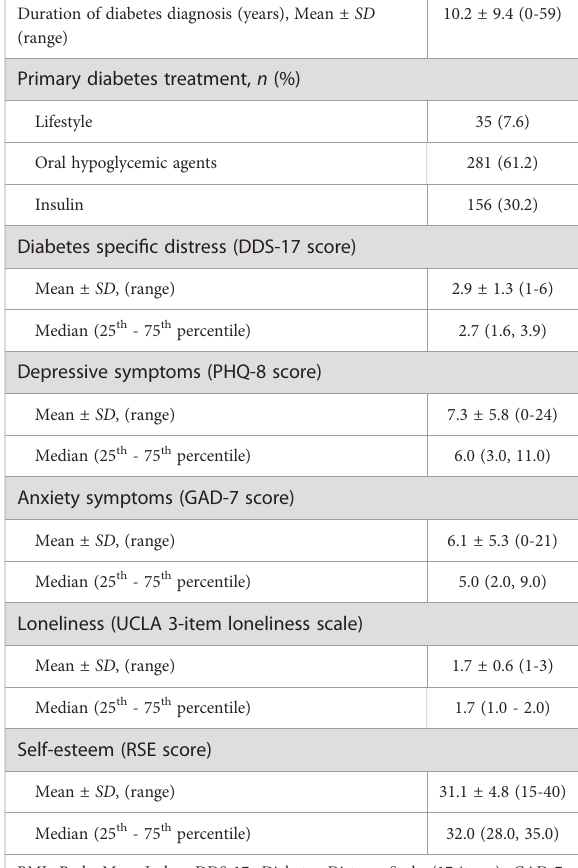
Exploratory factor analyses revealed that 82% of the variance in the participant responses to the 19 items of the DSAS-2 Spa- US was explained by a single factor (Table 2), with all the items loading >0.5. The scree plot also suggested a single factor because the eigenvalues level off after one factor (Figure 1). A three-factor solution was not apparent, suggesting that subscale scores are not supported for the DSAS-2 Spa-US. The internal reliability of the total DSAS-2 Spa-US scale was high ( a =0.93), supporting the calculation of a total DSAS-2 Spa-US score representing diabetes stigma. For all 19 items, the full range of response options was endorsed. The frequency distributions of the individual items had consistently positive skews, ranging from 0.21 to 1.45. The kurtosis for individual items was also consistently positive, ranging from 1.56 to 4.70. Missing response data for the individual items ranged from 1% to 4% (Table 3). Convergent validity was demonstrated with strong, positive correlations observed between diabetes stigma and general chronic illness stigma (r s =0.65, p<0.001) and diabetes distress